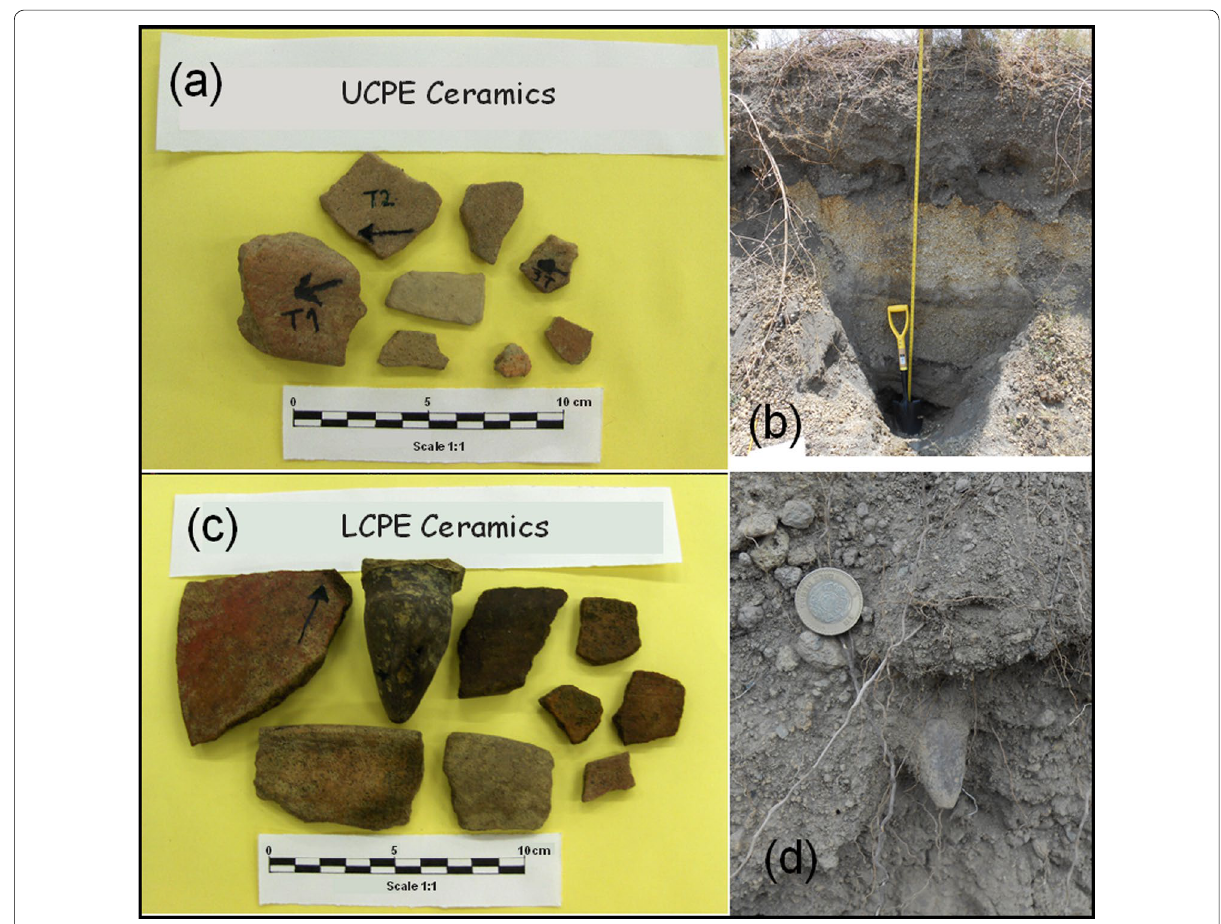
Fig. 5 Different ceramic shards studied. a Ceramic shards buried from the UCPE pyroclastic density current. b View of the UCPE pyroclastic density current. c Ceramic shards buried from the LCPE pyroclastic density current. d View of the LCPE pyroclastic density